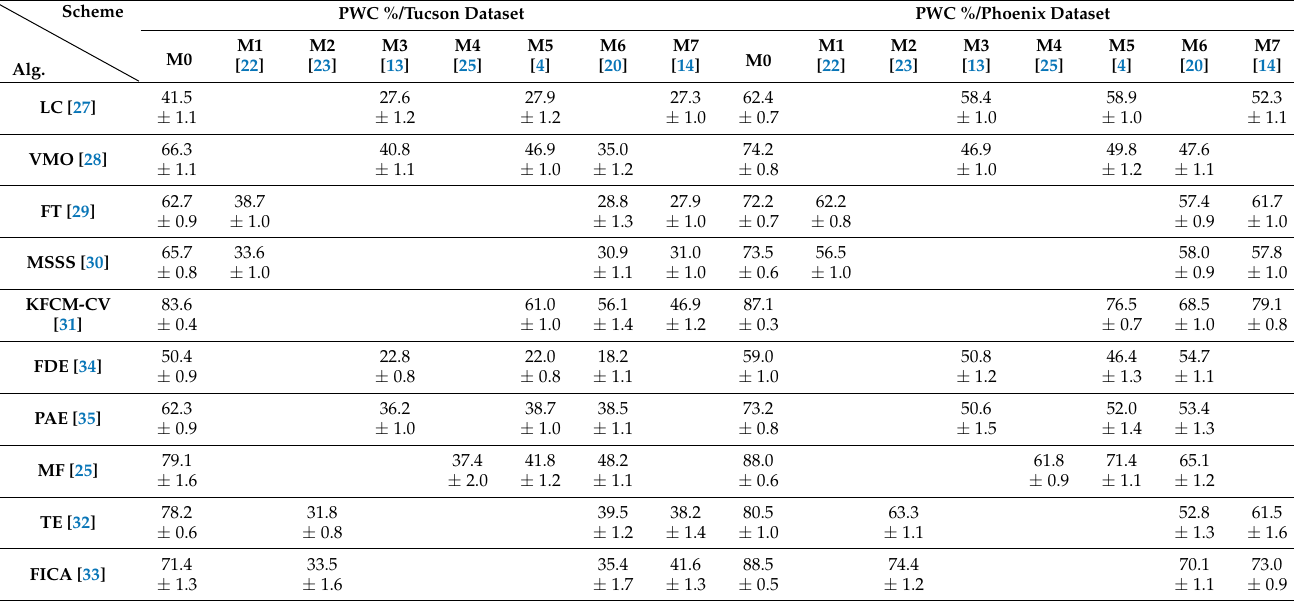
Table 5. PWC for ten algorithms before and after combining with their best three post-processing schemes.